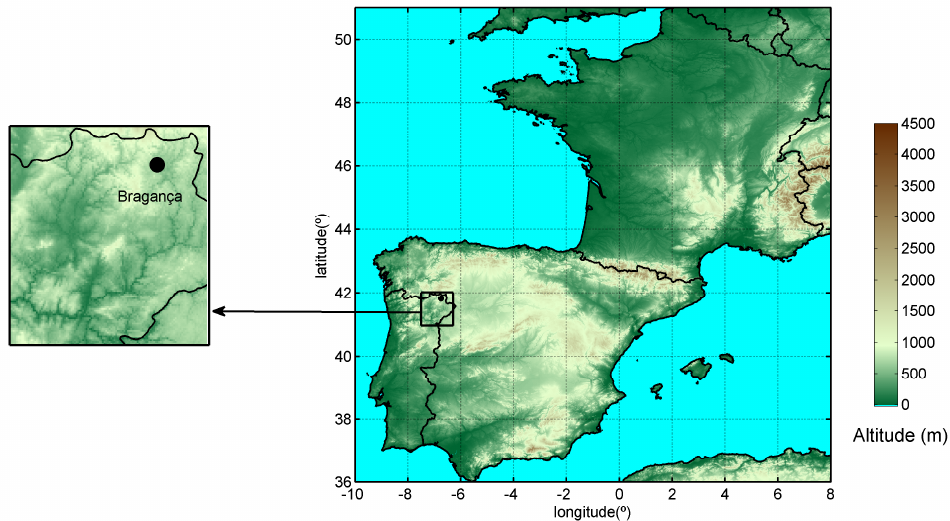
Fig. 1. Digital elevation model of Continental Portugal with spatial resolution of 1km × 1km. The colourbar represents the altitude (m). Location of Braganc¸a weather station is identified with a black circle. Figure 1. Digital elevation model of Continental Portugal with spatial resolution of 2 1 km × 1 km. The colorbar represents the altitude (m). Location of Bragança weather station 3 is identified with a black circle. 4